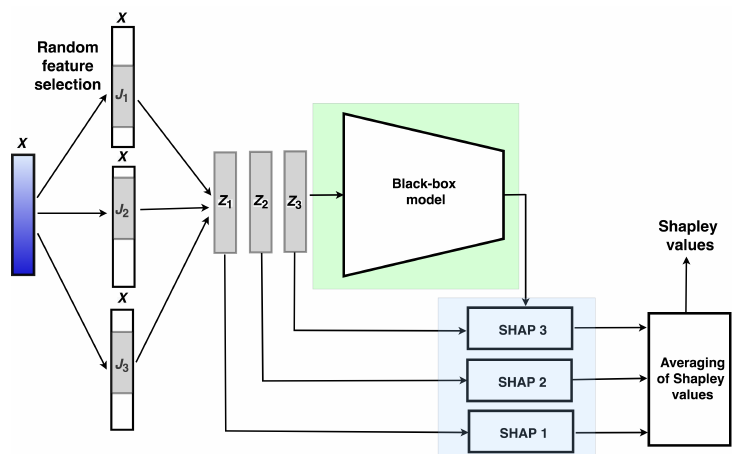
Figure 1. A scheme of the